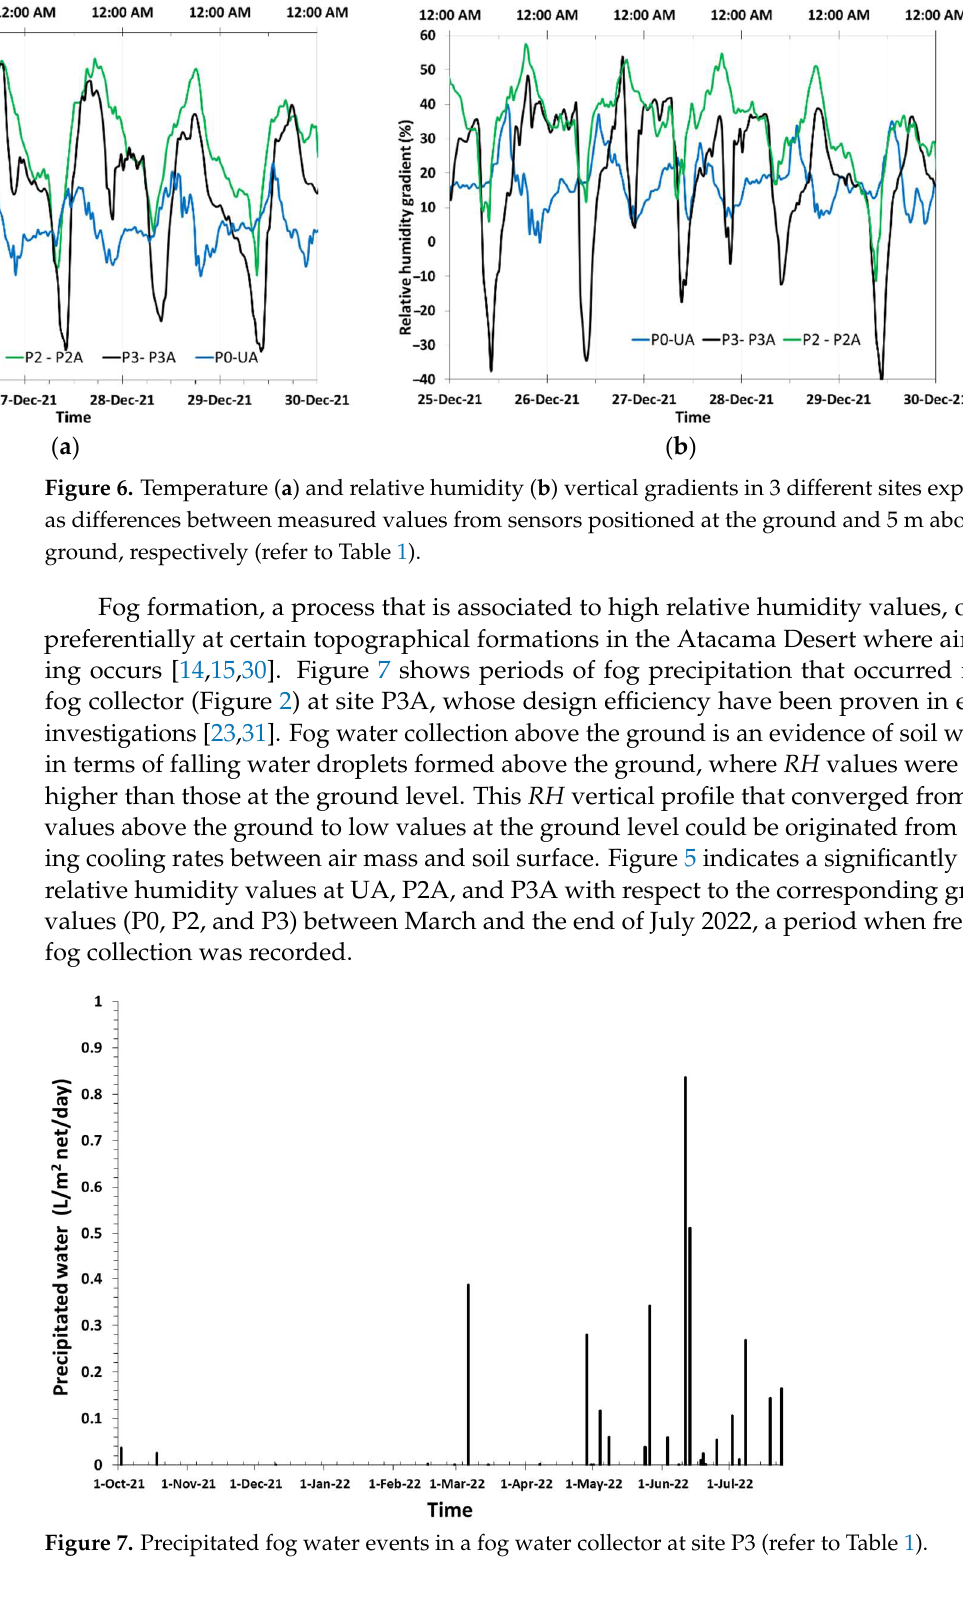
Figure 6 shows the typical daily patterns for the T and RH vertical gradients in three